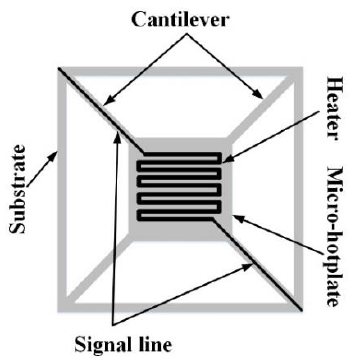
Figure 1. Classical design of a micro-hotplate (MHP) in a micro-Pirani vacuum